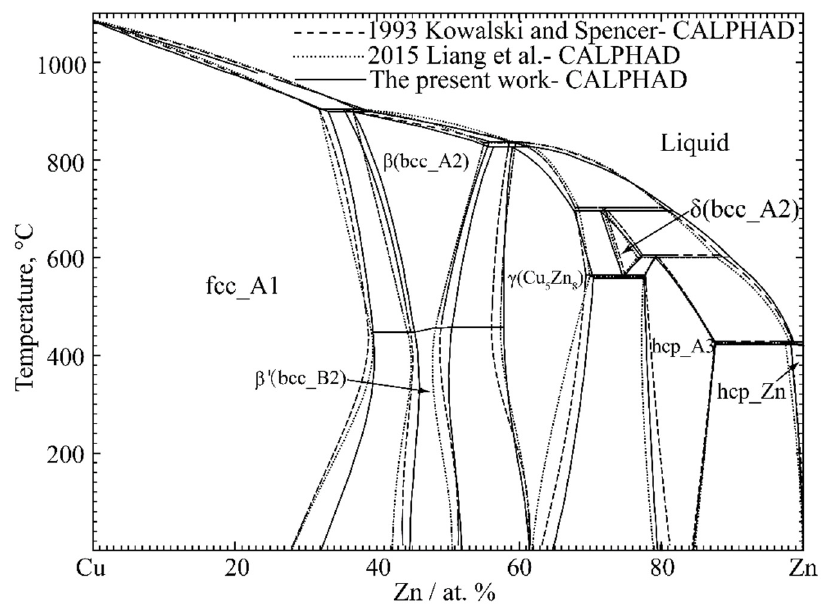
Figure 2. The calculated phase diagram of the Cu-Zn system compared with the previously optimized data from refs. [45,50]. Table 6. Optimized thermodynamic parameters of the solid solutions and compounds in the Cu- Zn, Cu-Se and Zn-Se binary systems.